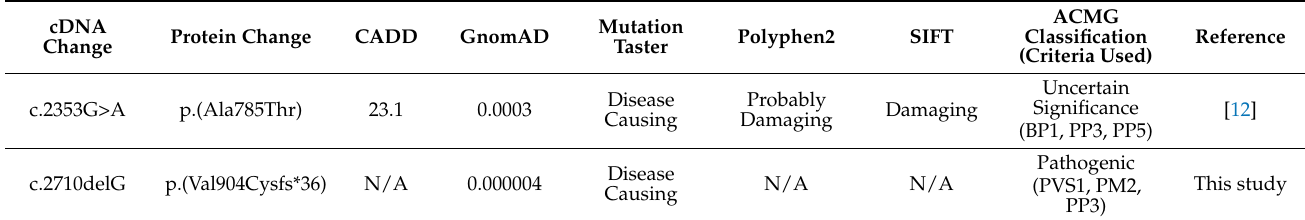
Table 1. EPHA2 variants, pathogenicity predictions and their ACMG